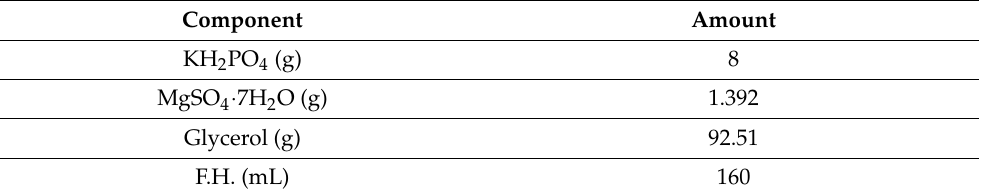
Table 5. Composition of the bioreactor medium for volume of 2000 mL (the remaining volume was supplemented with tap